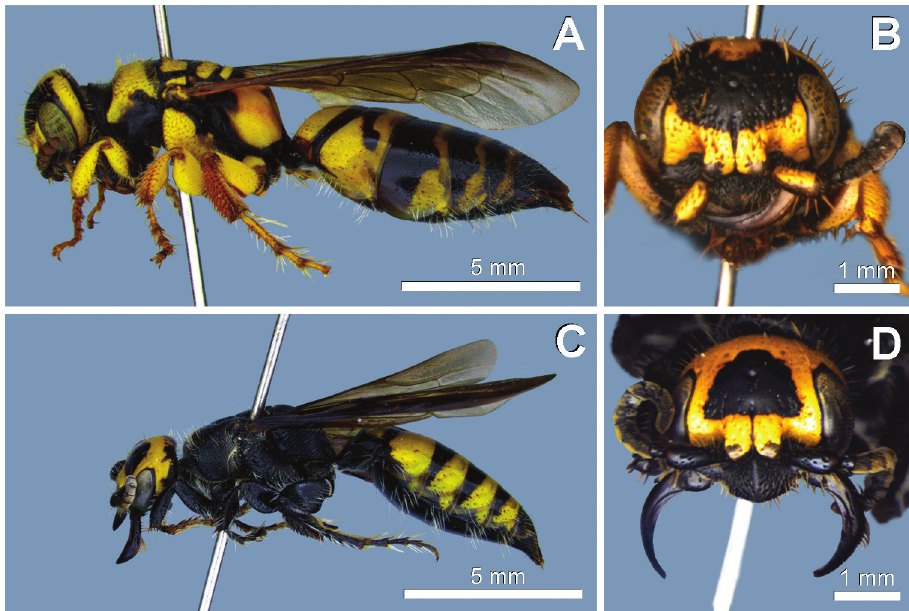
Figure 1. A, B Profile and frontal view of female of Myzinum sp.1. C, D Profile and frontal view of female of Myzinum